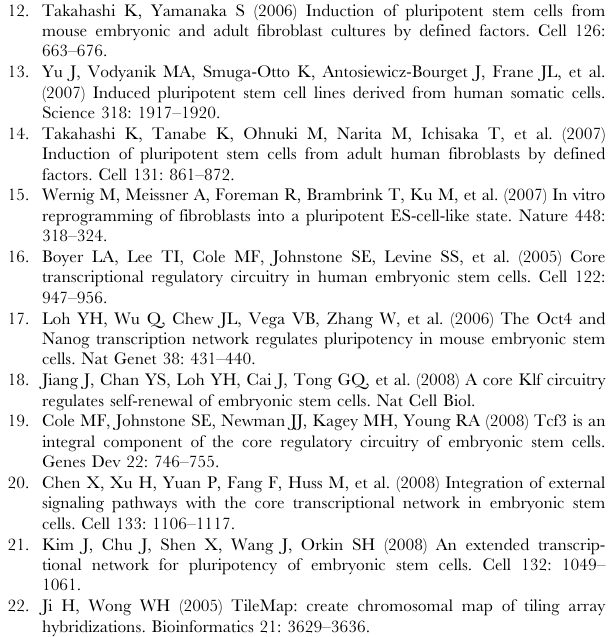
Table S2 c-Myc bound regions in murine ES cells